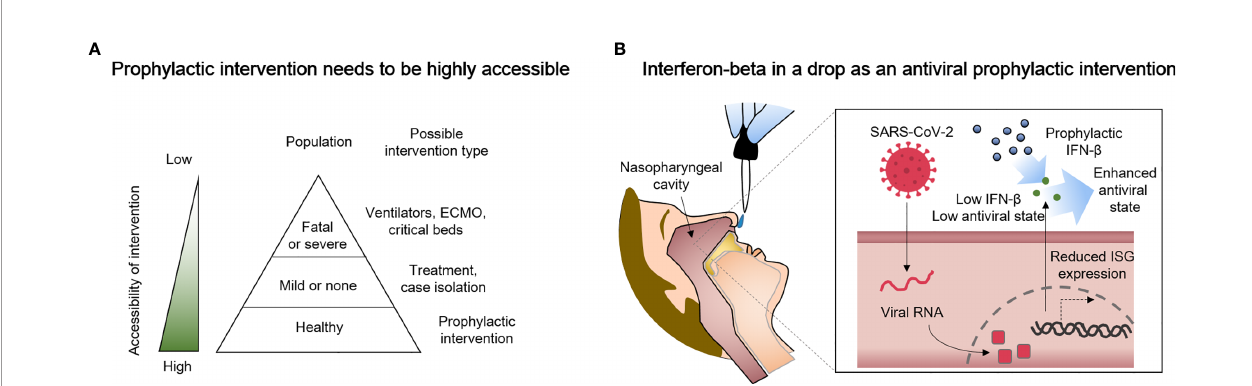
FIGURE 1 | Delivery of type I interferon-beta (IFN- b ) to the nasopharyngeal cavity is a candidate prophylactic and early intervention measure against COVID-19 that has high potential for success. (A) A greater accessibility of the intervention can prevent shortages of ventilators, extracorporeal membrane oxygenation (ECMO) machines, and/or critical care beds. (B) Suggested in this perspective is the highly accessible delivery of IFN- b to the nasopharyngeal cavity. The administered IFN- b can partially compensate for reduced interferon-stimulated gene ( ISG ) expression in SARS-CoV-2-infected cells as way to enhance antiviral